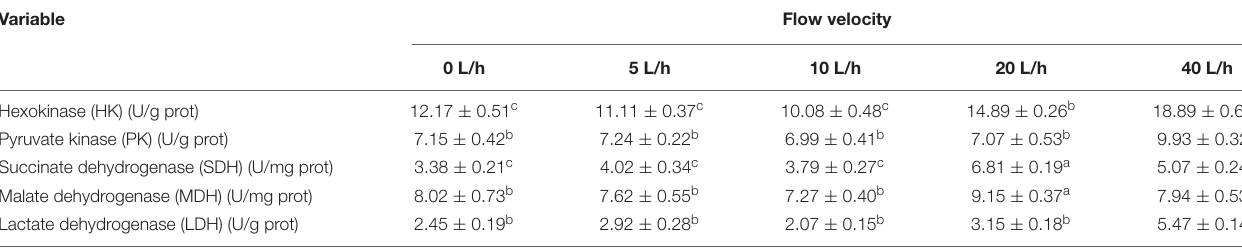
TABLE 5 | Effect of flow velocity on the activity of metabolic enzymes of H. discus hannai larvae.